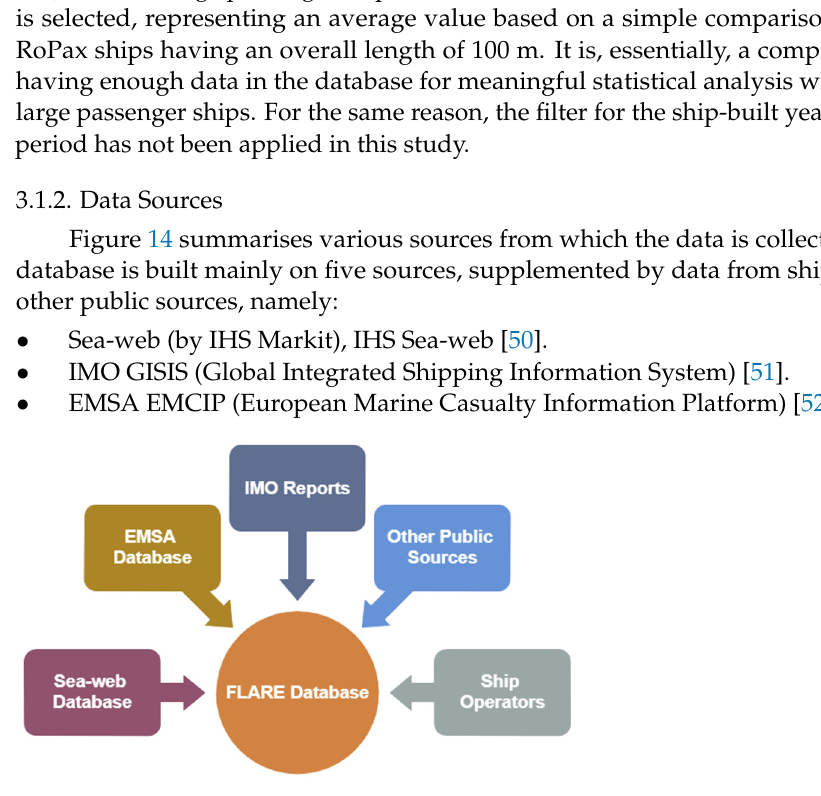
Table 1 . Number of accident cases providing qualitative measures of hull damage positions . Damage Position